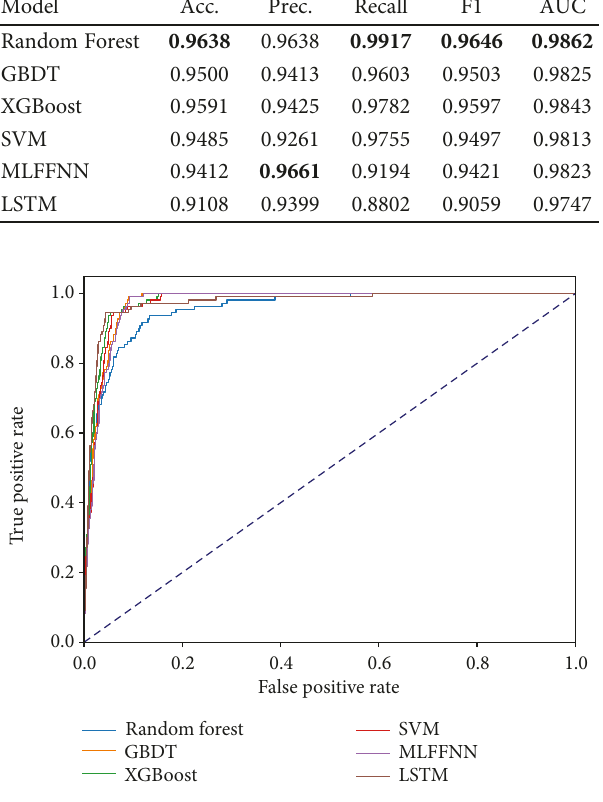
Figure 5: The receiver operating characteristic curve of six methods with all processed